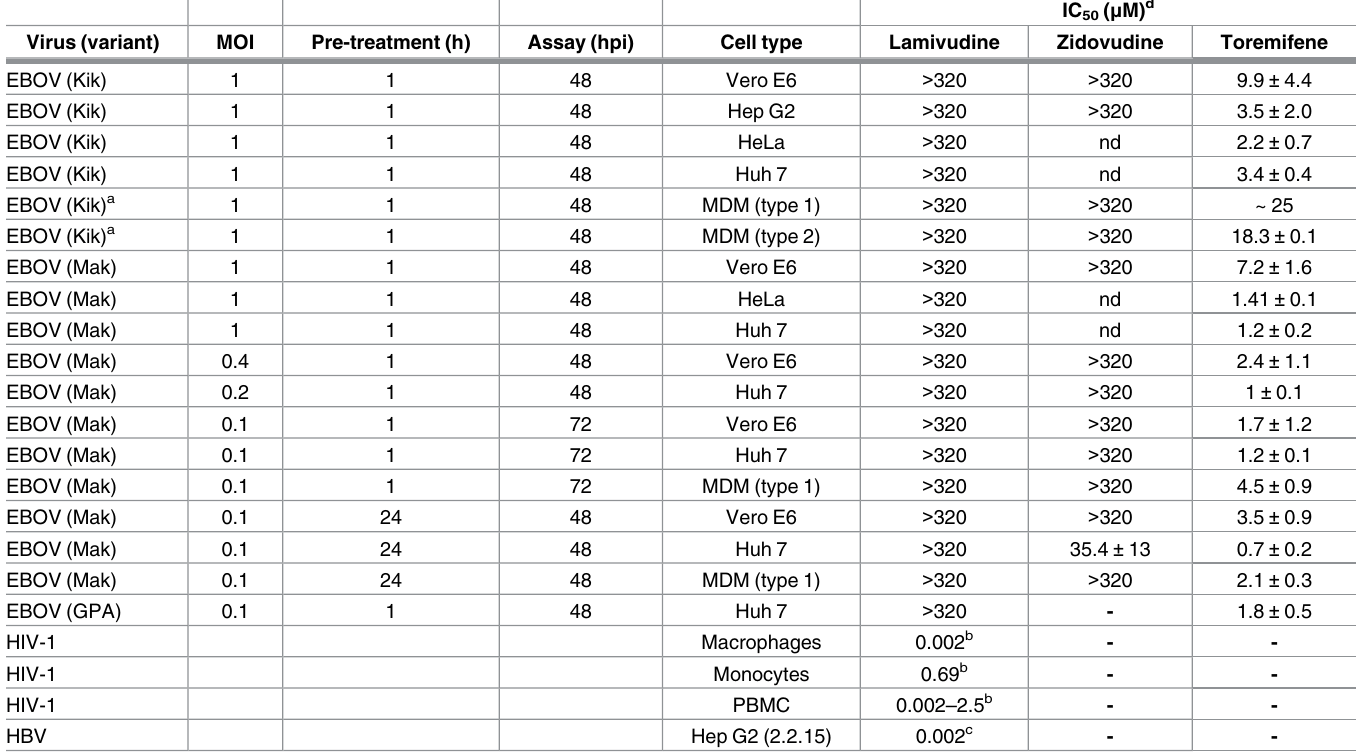
Table 1. Effects of Lamivudine, Zidovudine, and Toremifene Citrate on Ebola Virus